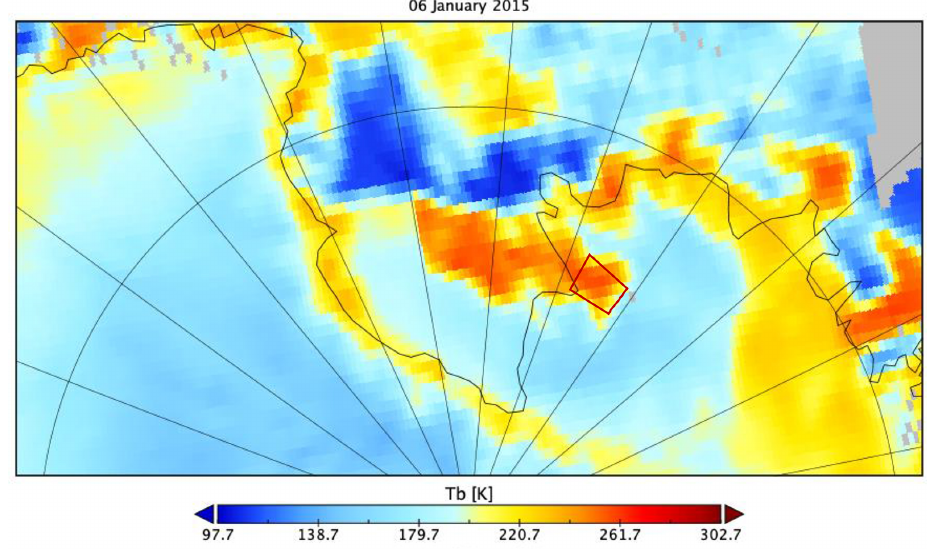
Figure B1. SSMIS horizontally polarized 19.35GHz brightness temperature over West Antarctica and the RIS on 6 January 2015, with the red box denoting the Siple Dome bounding region used in the case